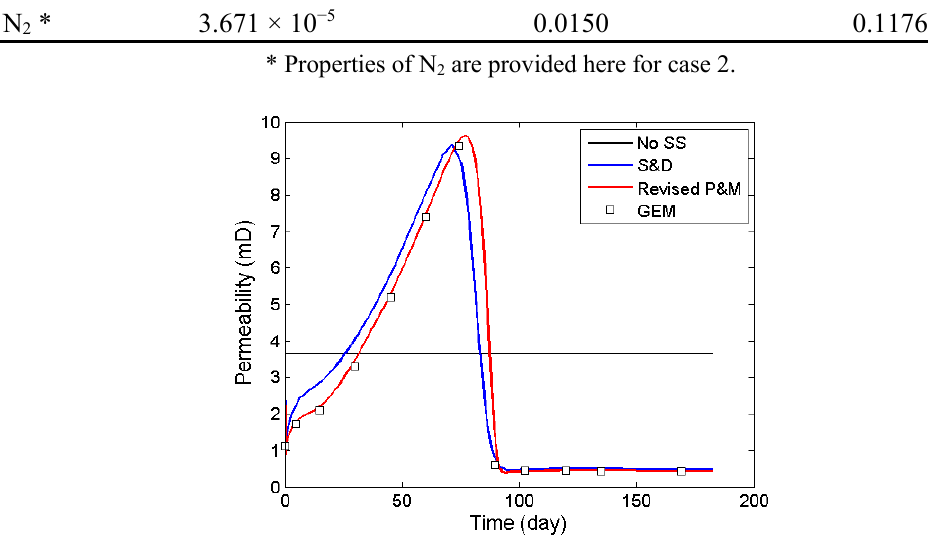
Figure 7. Comparison of producer block permeability for different models.